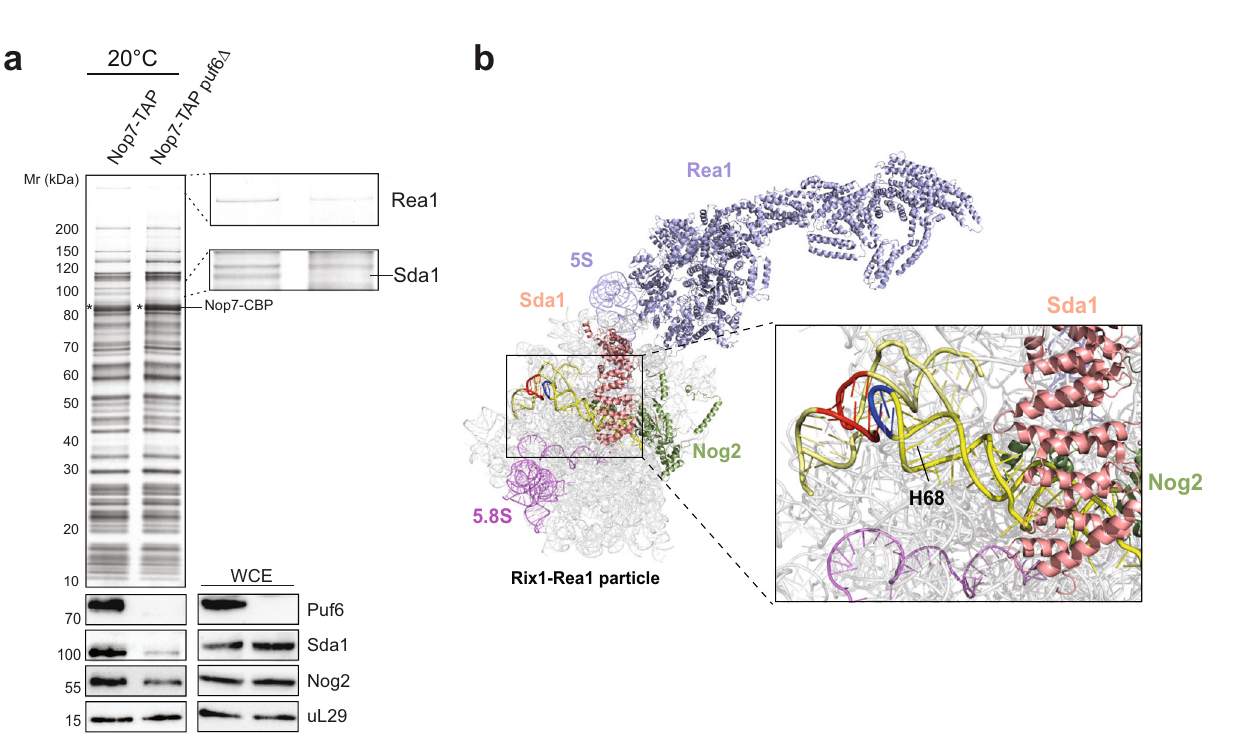
Fig. 7 Puf6 primes a 60S pre-ribosome for nuclear export. a Nop7-TAP particles isolated from WT and puf6 Δ cells were grown at 20 °C and separated on a NuPAGE 4 – 12% Bis-Tris gradient gel, analyzed by Silver staining and Western analysis using indicated antibodies. Prior to TAP, whole cell extracts (WCE) from the indicated yeast strains were separated by SDS-PAGE and analyzed by Western blotting using indicated antibodies. uL29 was used as a loading control. The bait protein Nop7-CBP is indicated by an asterisk. b Puf6 binding site overlaps with Sda1 (salmon) and Nog2 (green) on the early 60S pre-ribosome (PDB ID: 6YLH 15 ). Source data are provided as a Source Data fi Cryo-EM structures of early nucleolar states implicate a non- linear pathway to compact 27S pre-rRNA. Initially, the 5 ′ rRNA domains I and II of 27S pre-rRNA adopt a near mature con- formation through tertiary contacts with the 3 ′ terminal domain VI, to form the solvent-exposed backside of the 60S subunit. In contrast, the central rRNA domains III, IV, and V, which even- tually form the subunit interface appear to be dynamic and are